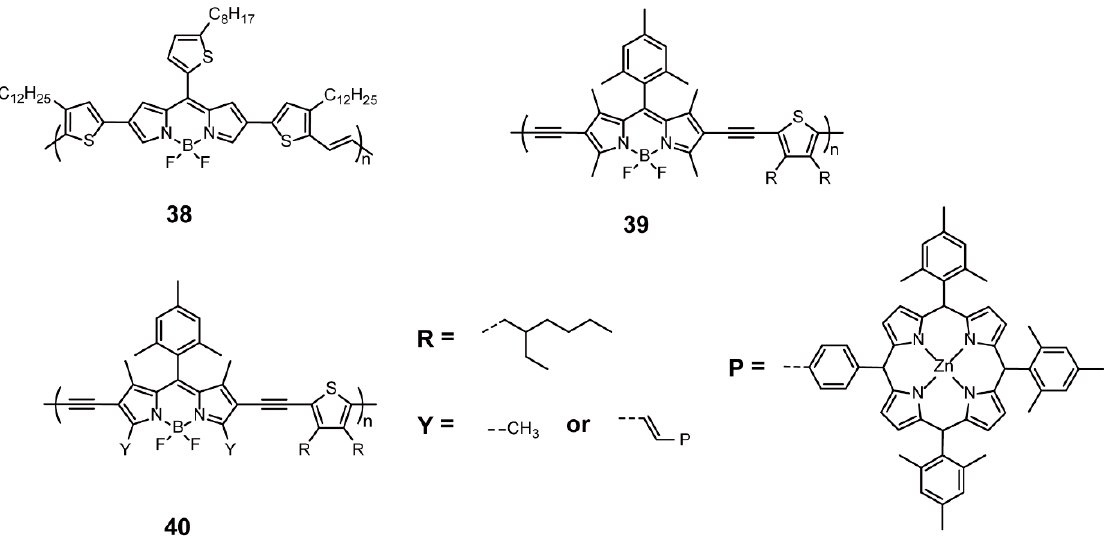
Figure 13. Chemical structures of polymers 38 – 40 (Reproduced with permission from Reference [74]. Copyright @ 2018, American Chemical Society. Reproduced with permission from Reference [75]. Copyright @ 2015, Royal Society of Chemistry).